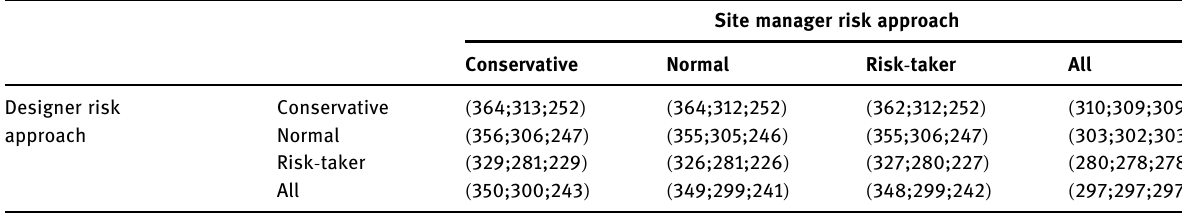
Table 6: Average project completion time ( days ) for various worker experience ratings ( little; average; high )